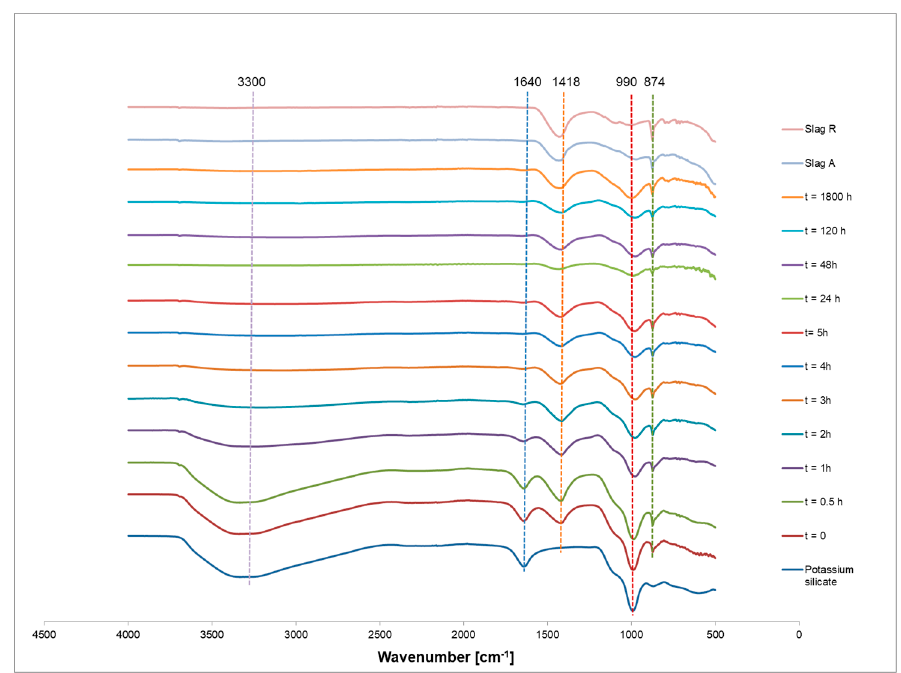
Figure 6. Time dependent FTIR spectra of for the precursors, alkali activator and AAM (A/R: 1/1 specimen cured at room temperature).